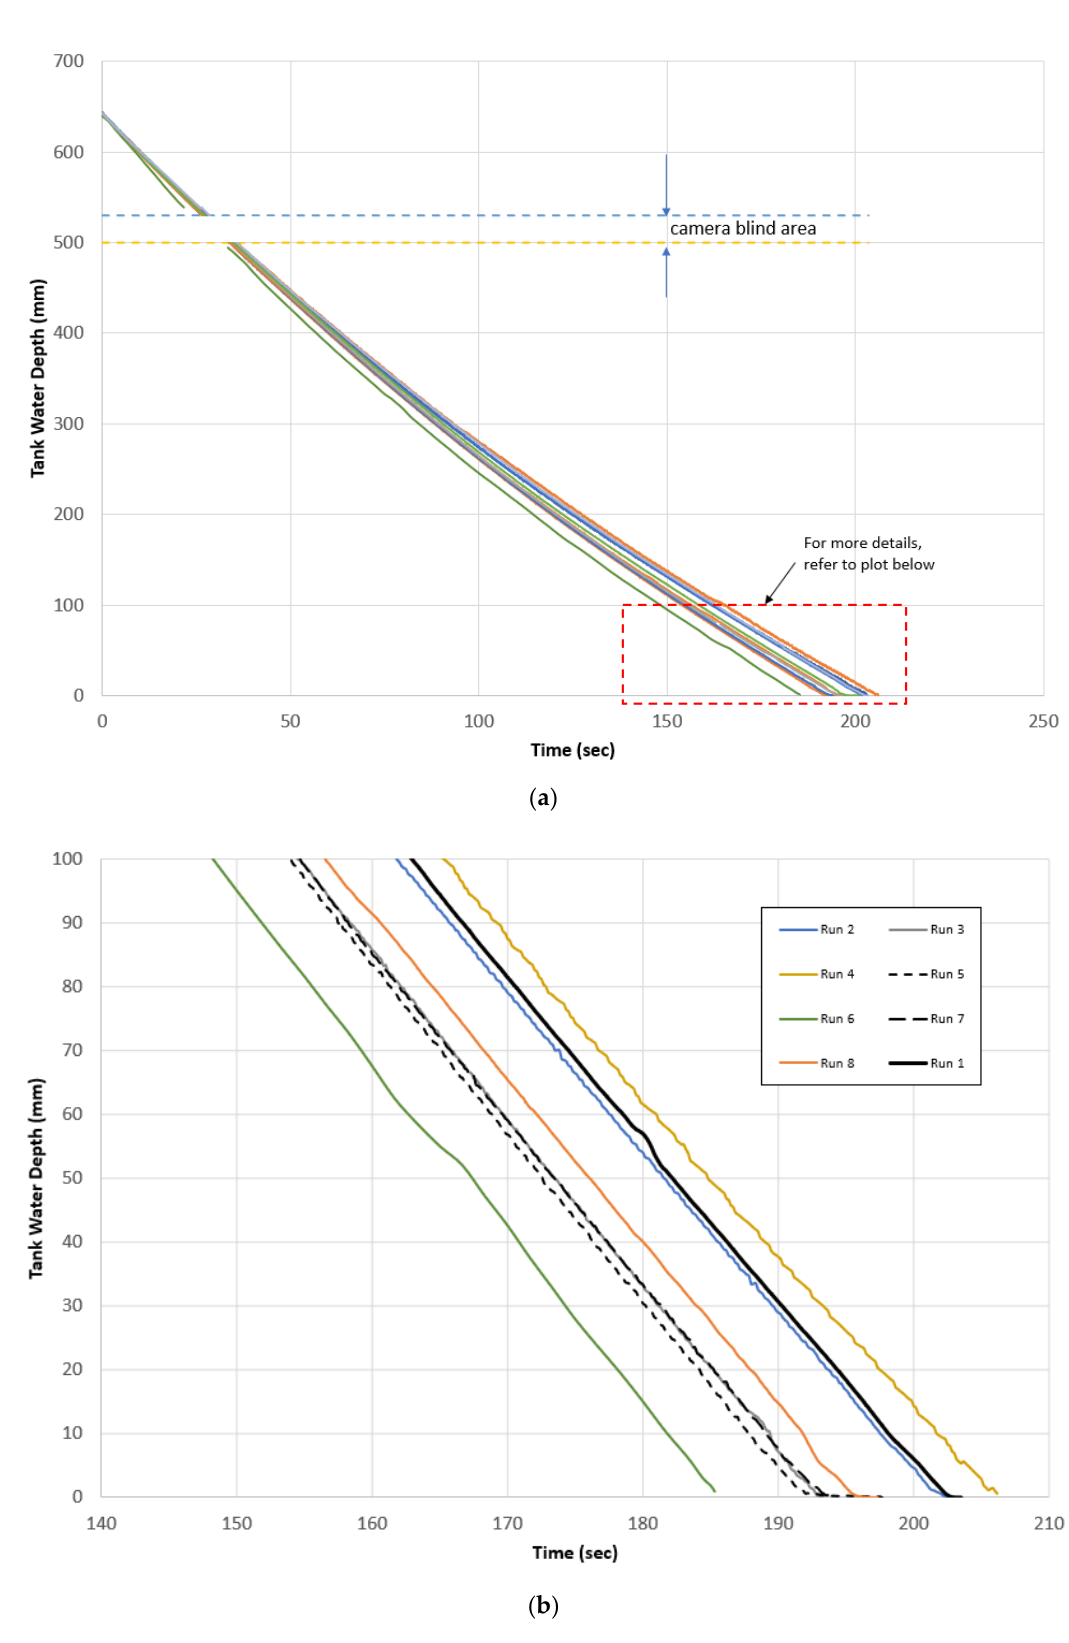
Figure 7. Temporal variations of tank water depth using different passive rotors: ( a ) full data measurement range; ( b ) zoom in for the dashed window shown in panel a.